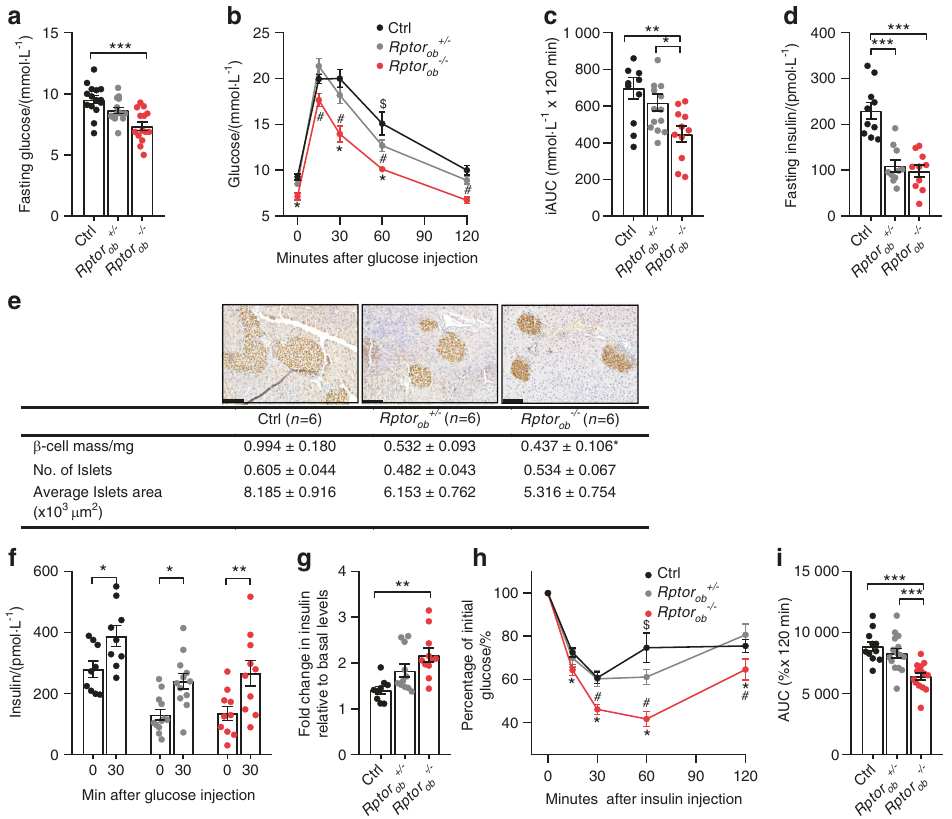
Fig. 2 NCD-fed Rptor ob − / − mice display an improvement in glucose metabolism. a Fasting blood glucose levels in 9-week-old mice ( n = 15/ genotype). b GTT blood glucose levels in 9-week-old mice, and c incremental area under the curve analysis ( n = 11 – 14/genotype). d Fasting serum insulin levels ( n = 10/genotype). e Representative images of insulin immunostaining in pancreas samples from 9-week-old mice. Scale bars = 100 µm and histomorphometric analysis of β -cell area, islet number, and islet size ( n = 6/genotype). f Glucose-stimulated insulin levels and g fold change in insulin levels at 30 min relative to basal levels ( n = 9 – 12/genotype). h ITT blood glucose levels in 8-week-old mice and i area under the curve analysis ( n = 11 – 15/group). All panels except b and h : data are expressed as mean ± SEM. * P < 0.05, ** P < 0.01, *** P < 0.001, one-way ANOVA with Tukey ’ s post hoc test. b , h * P < 0.05 between Rptor ob − / − and Ctrl, # P < 0.05 between Rptor ob − / − and Rptor ob + / − and $ P < 0.05 between Rptor ob + / − and Ctrl, two-way ANOVA with Tukey ’ s post hoc